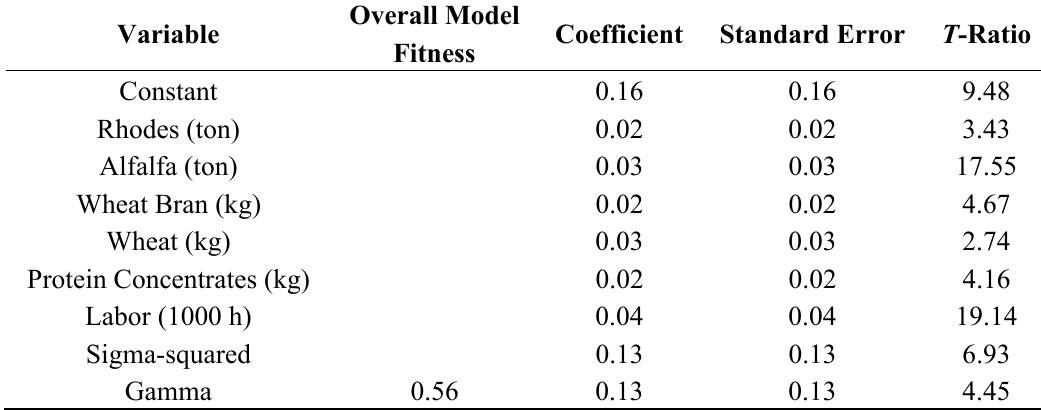
Table 4. Sheep maximum likelihood estimates: stochastic production frontier.